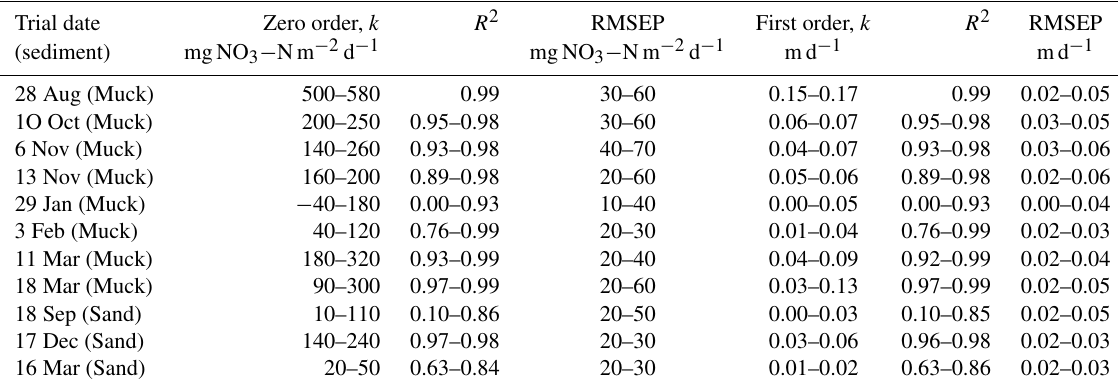
Table 4. Time series of NO − concentrations in Sediment mesocosms were fitted to zero- and first-order kinetics models. Results indicate 3 that for this short-duration experiment ( < 24h) and at the observed range of NO − described equally well by either model, although first-order kinetics better fitted NO − concentration. RMSEP refers to the root mean square error of